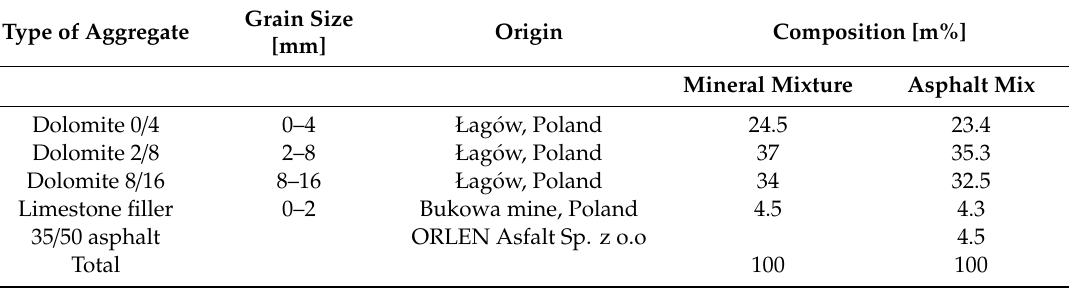
Table 3. Composition of mineral mixture and asphalt mix.